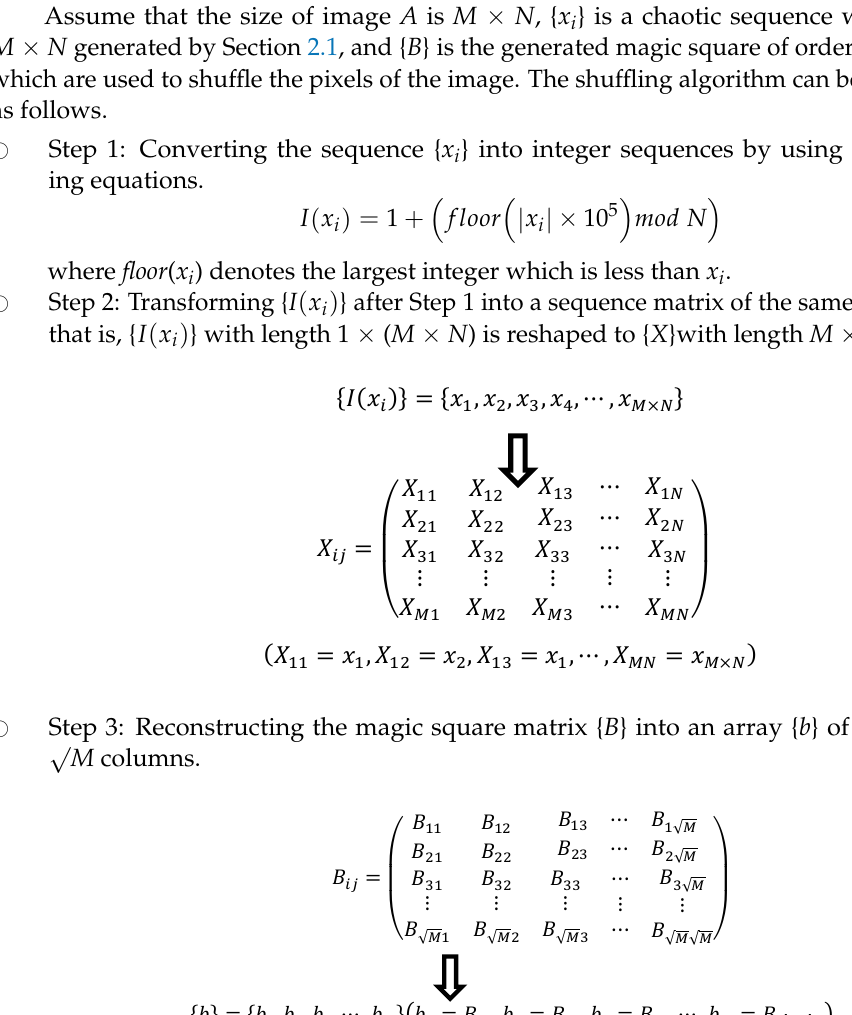
Figure 9. Bifurcation diagrams: ( a ) The original chaotic map; ( b ) The improved chaotic map.